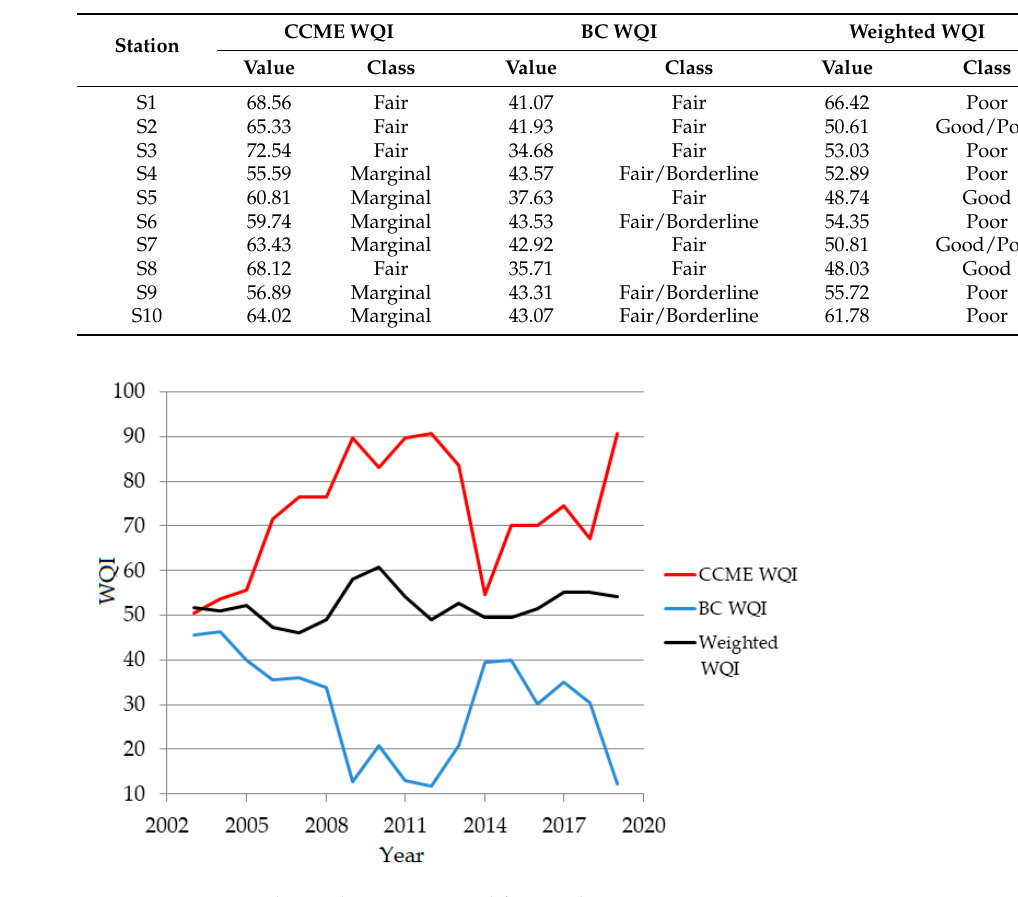
Figure 4. Water quality indexes computed for each station. Table 3. Water quality indexes at each station for the study period.